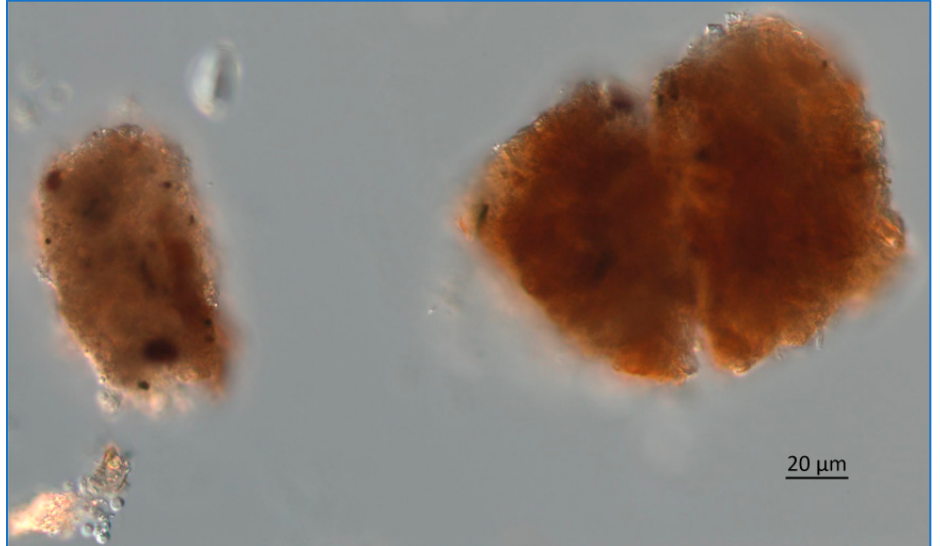
Figure 15. Lake Okeechobee snow from 3.2 m depth, June 2020. These are fecal pellets from zooplankton. The image was obtained using a Zeiss AX10 microscope equipped with DIC and a digital imaging system.